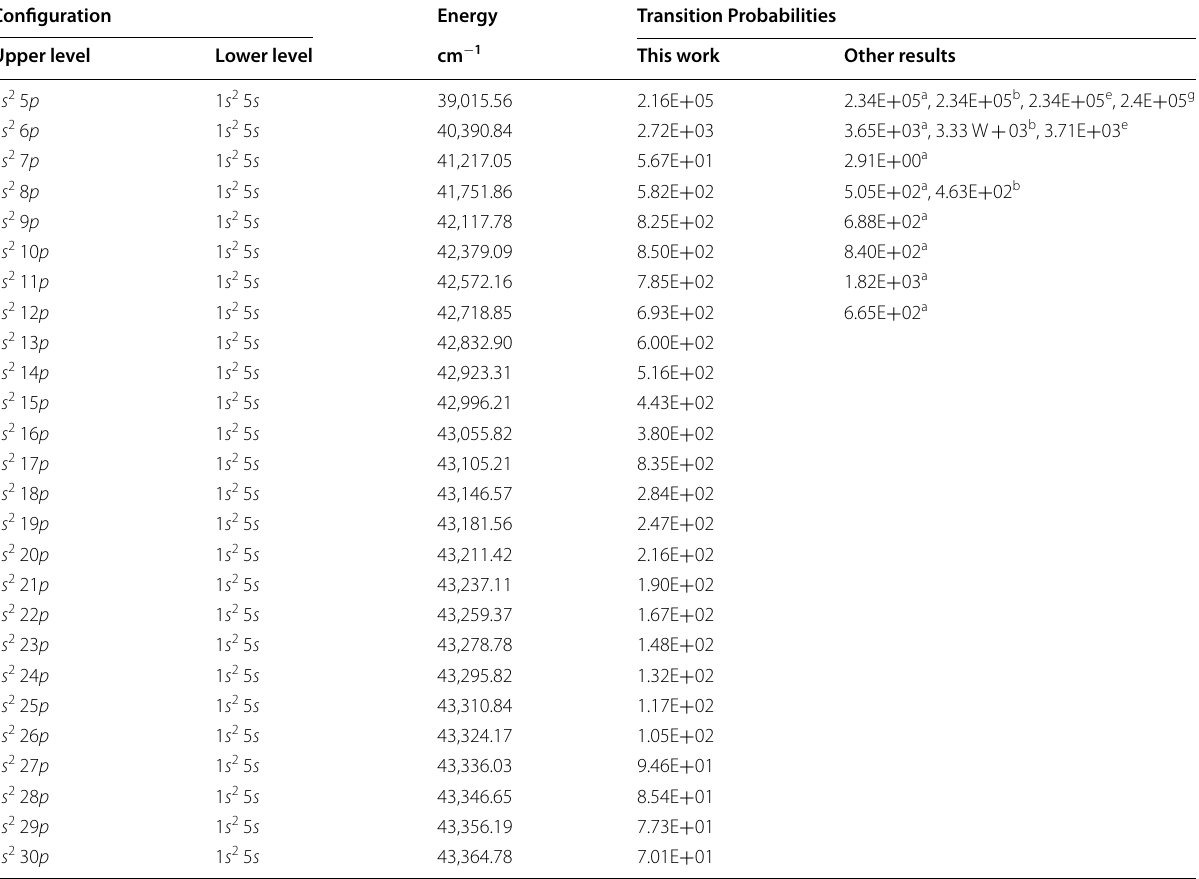
Table 4 Transition probabilities for the transitions 1 s 2 np –1 s 2 5 s calculated in this work compared with other